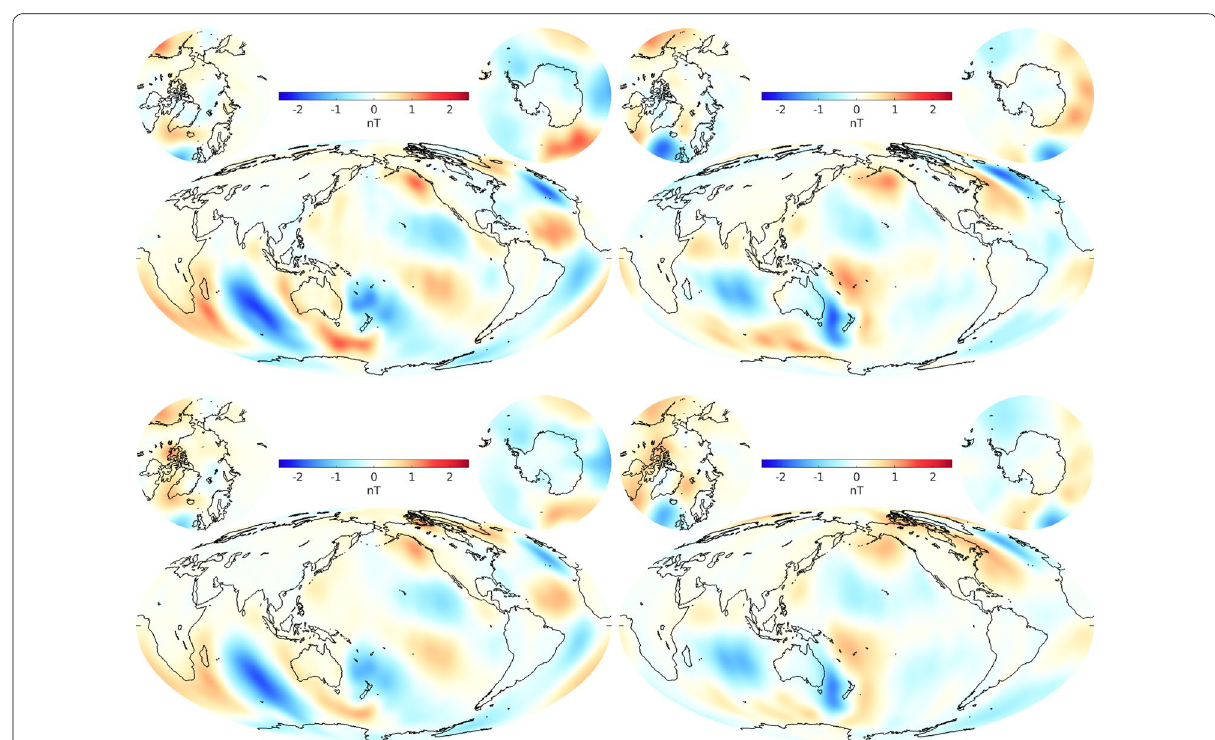
1 28 at satellite = −